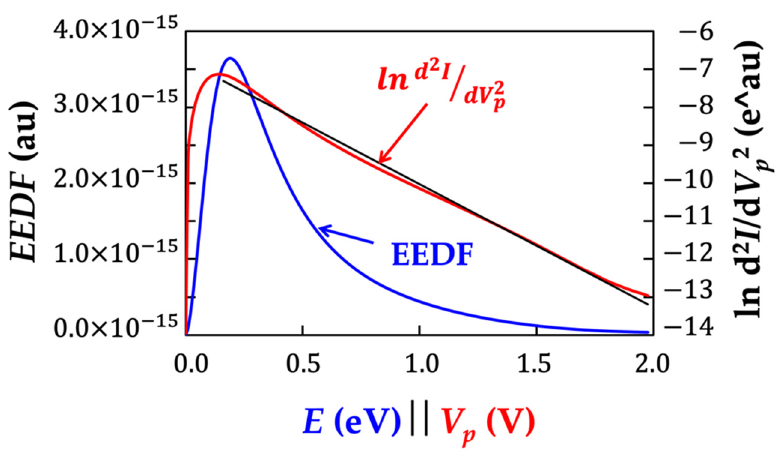
Figure 11. EEDF and ln d 2 I / dV 2 p - V p curve obtained from the IVCP of Figure 4. Both contain 76 points. The linear zone fits very well with a linear behavior (black straight line) since the correlation coefficient of the linear regression is r = 0.998.